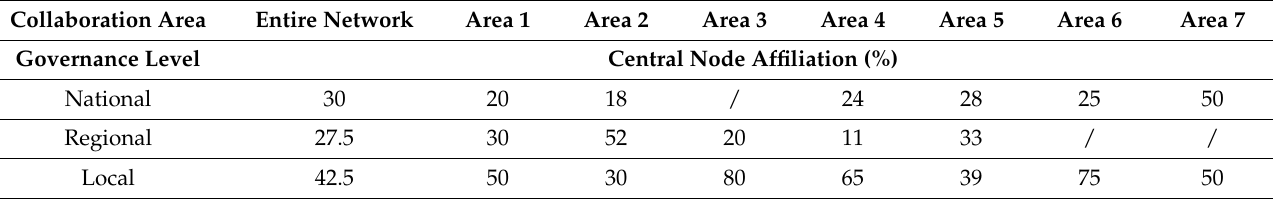
Table A5. Overview of the organizations affiliation to the central node for the entire network and per collaboration area. Collaboration